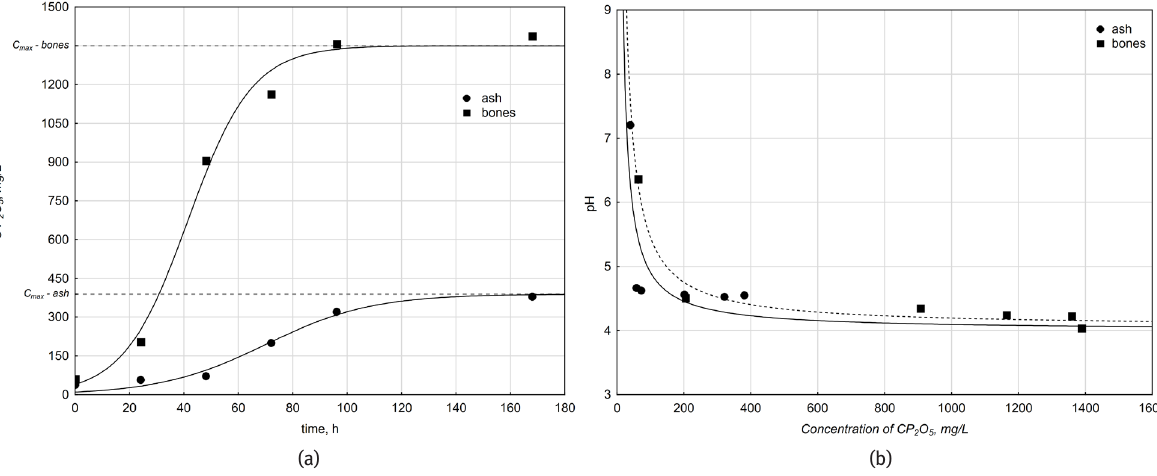
O ) during the solubilization process; b) The relationship between the 2 5